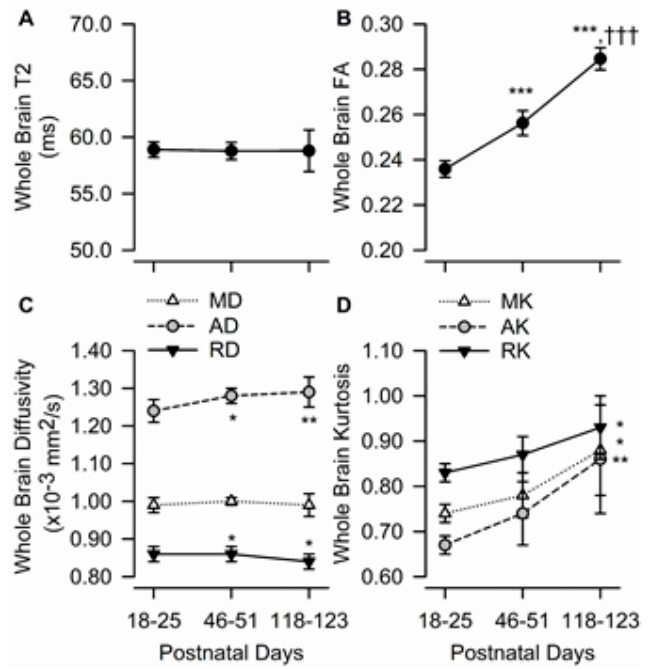
Figure 2. Age dependence of T 2 , fractional anisotropy, diffusivity, and kurtosis measures in the whole brain of male guinea pigs. Graphs illustrate the age dependence of T 2 ( A ), fractional anisotropy (FA) ( B ), diffusivity measures ( C ), and kurtosis measures ( D ) in the guinea pig brain. Symbols and error bars represent mean and SD of results obtained from 6 guinea pigs examined longitudinally at postnatal day (PND) 18-25 (juvenile), PND 46-51 (adolescent), and PND 118-123 (adult). Whenever ANOVA revealed a significant effect of age on a given parameter, the Tukey post-hoc test was used for multi-group comparisons. Asterisks and daggers are used for comparison with data obtained at PND 18-25 and PND 46-51, respectively. *, p < 0.05, **, p < 0.01, ***, p < 0.001; †††, p < 0.001.